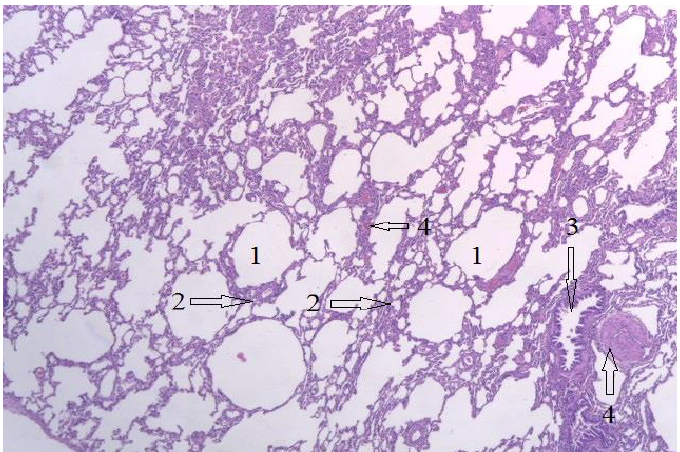
Figure 24. Muscle tissue, Hematoxylin–Eosin stain; 10 × 10 magnitude. 1-Hydrogen bubbles, 2-Normal muscle fibers, 3-Normal aspect of the nuclei.